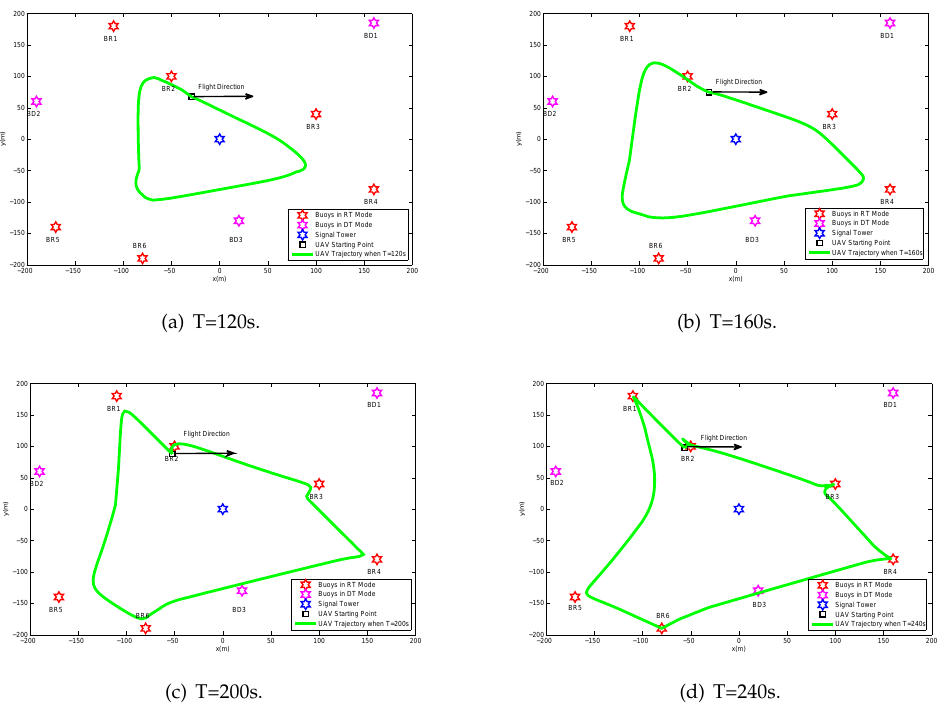
Figure 7. The UAV trajectories of different periods T for the case B k [ 0 ] >